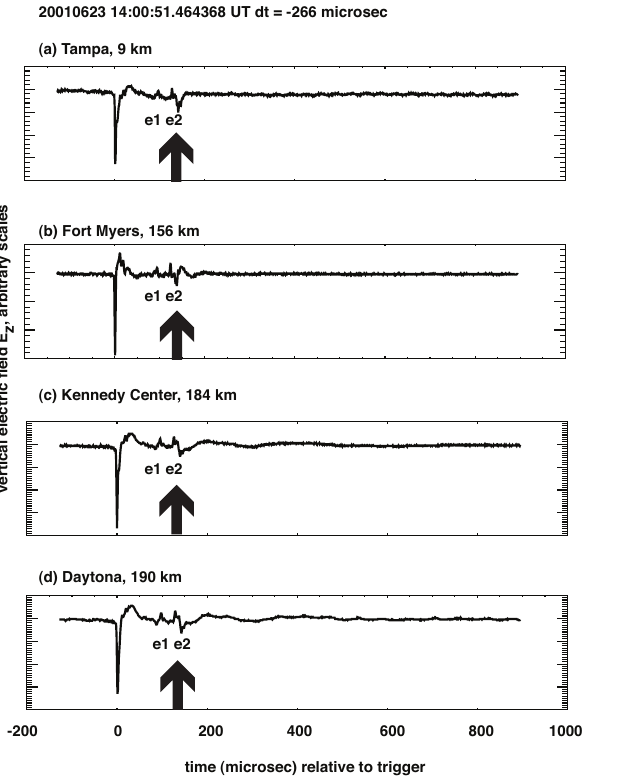
Fig. 4. Sferic electric field versus time for the four participating stations of one of the tightly-coincident sferics classified as an NBE (line #1 in Table 2). The arrows pointing at the second pulse are at the same time in each record. The “echoes” do not behave like ionospheric reflections, because they are roughly comparable in rel- ative strength regardless of range, and because their delay (from the ground wave) is also independent of range. Apparently this sferic is actually due to a negative cloud-to-ground stroke, and the “echoes” are a detail of the groundwave.